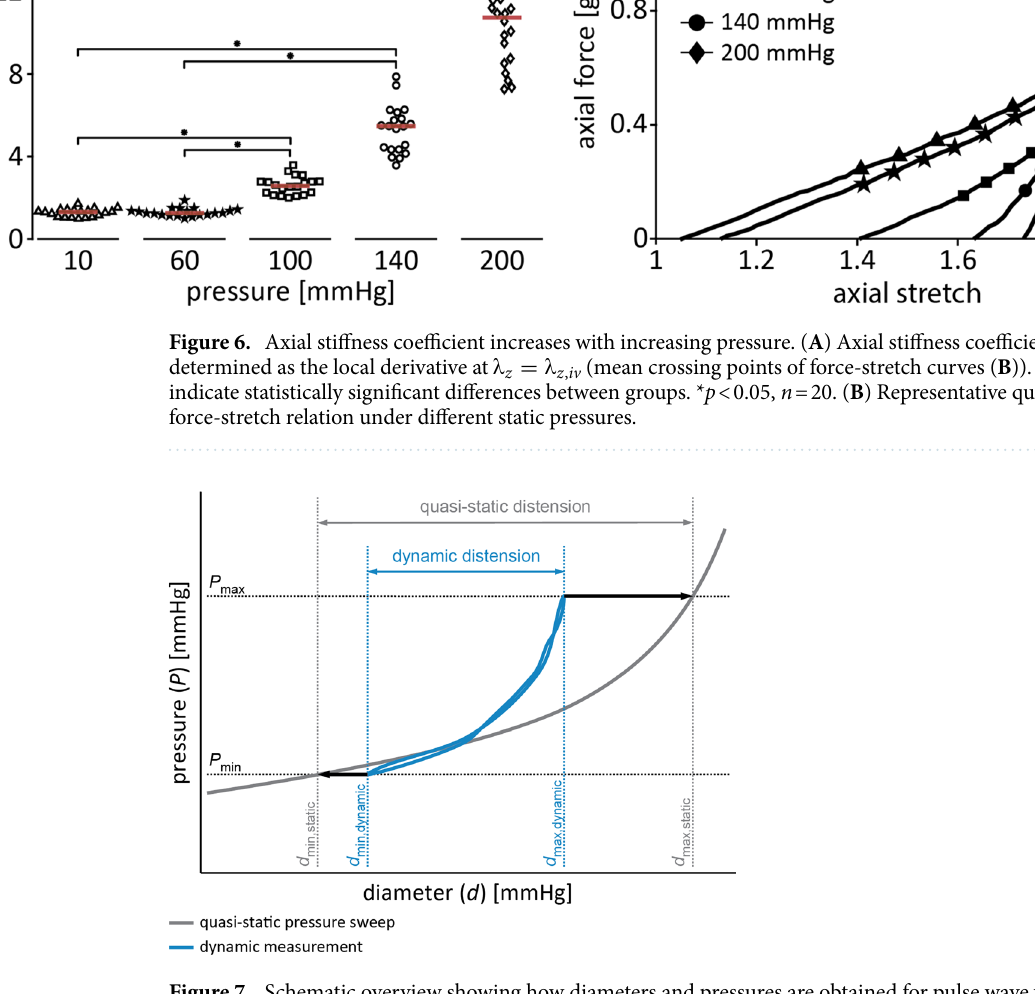
Figure 7. Schematic overview showing how diameters and pressures are obtained for pulse wave velocity calculation for both quasi-static and dynamic experiments. Maximum and minimum pressure ( P max and P min , respectively) are taken from the dynamic measurement. At these given pressures, the corresponding minimum and maximum diameters ( d min and d max ) are obtained for the dynamic (blue line) and quasi-static (grey line) diameter